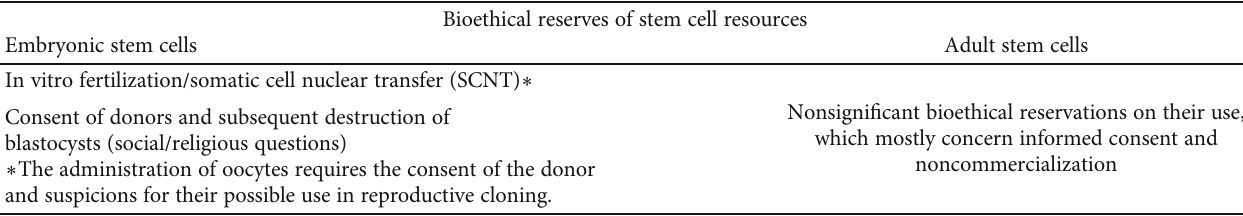
Table 3: Main bioethical concerns of stem